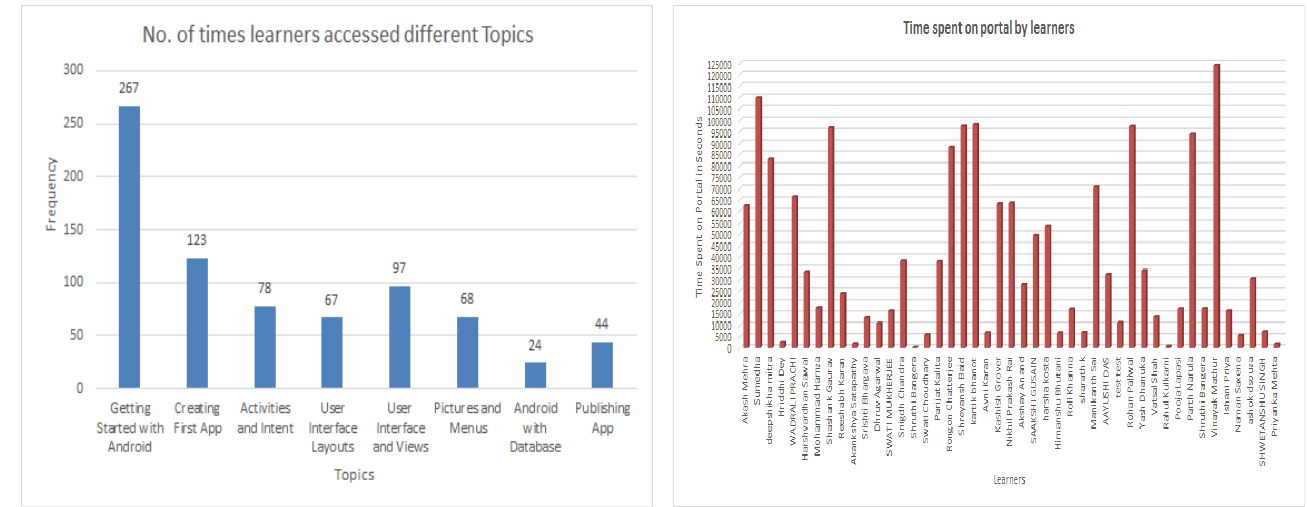
Figure 6. Analysis of Number of Times Learners